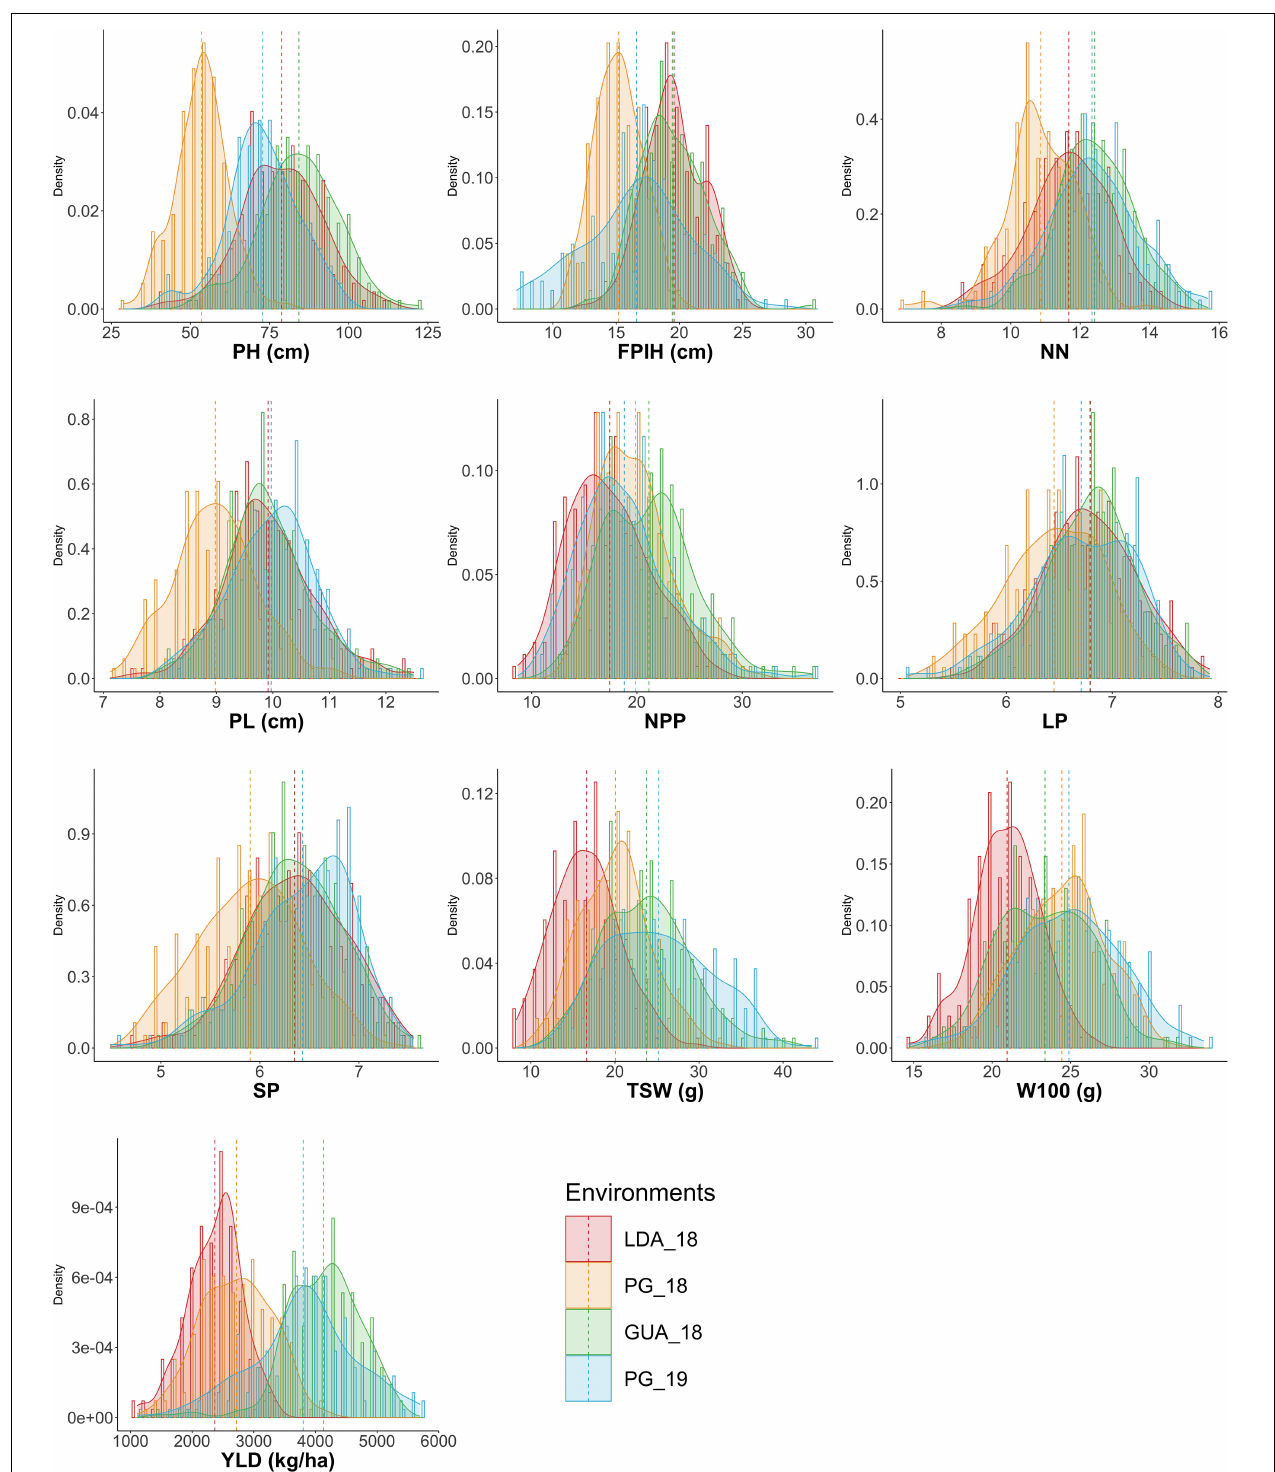
FIGURE 1 | Histogram and density plot of the ten morpho-agronomic traits evaluated in different locations and seasons in common bean accessions belonging to the Brazilian Diversity Panel (BDP). PH, plant height (cm); FPIH, first pod insertion height (cm); NN, number of nodules; PL, pod length (cm); NPP, total number of pods per plant; LP, number of locules per pod; SP, number of seeds per pod; TSW, total seed weight per plant (g); W100, 100-seed weight (g); YLD, grain yield (kg.ha - 1 ). Environments, 2018 rainy season crops: LDA_A18 = Londrina, PG_A18 = Ponta Grossa and GUA_18 = Guarapuava; 2018/2019 dry season crop: PG_S19 = Ponta